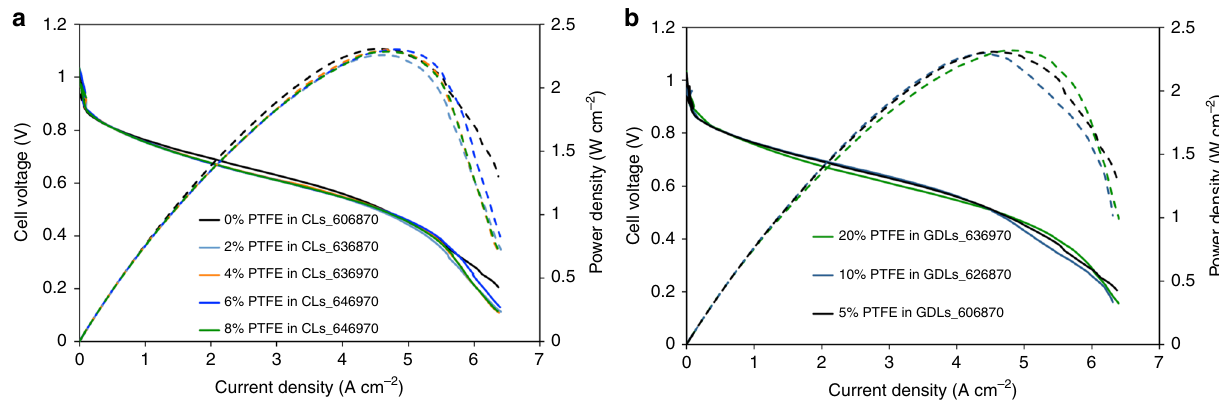
Fig. 6 CL and GDL hydrophobicity effects on AMFC performance. a i-V and i-power density curves (10 mV s − 1 forward scans) at optimal conditions in AMFCs. The CL PTFE was increased from 0 to 8 wt% with constant ionomer/carbon ratio of 0.4. The GDL PTFE content was kept constant at 5%; ( b ) i-V and i-power density curves (10 mV s − 1 forward scans) at optimal condition in AMFCs. The GDL PTFE contents for both anode and cathode were tested at 5%, 10%, and 20%. The anode and cathode loading were 0.70 mg PtRu cm − 2 and 0.60 mg Pt cm − 2 , respectively. The CLs PTFE mass content was kept at 0%. The membranes used in all tests were HDPE 5 . The cells were tested at 70 °C. The data is presented without iR-correction.